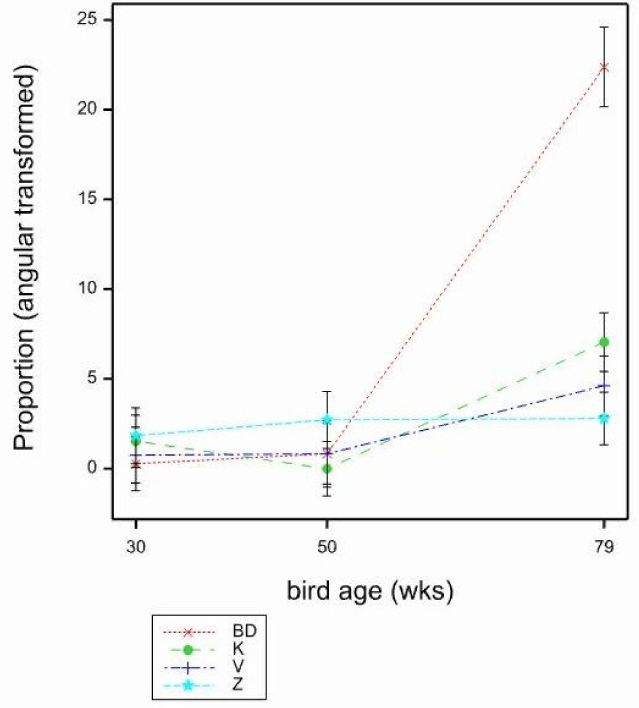
Figure 9. Mean proportions (angular transformed) of cracked eggs per location by bird age (weeks) and mat type estimated from LMM. Mean SE